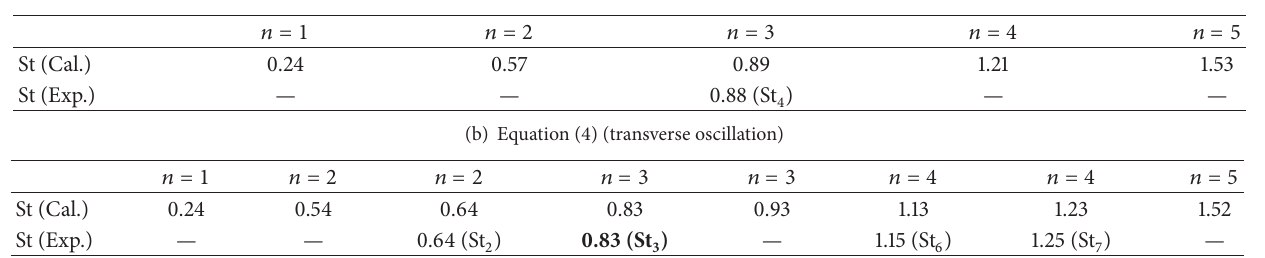
Table 1: Strouhal numbers of pressure oscillations resulting from feedback mechanism for 𝐿/𝐷 = 0.70 .